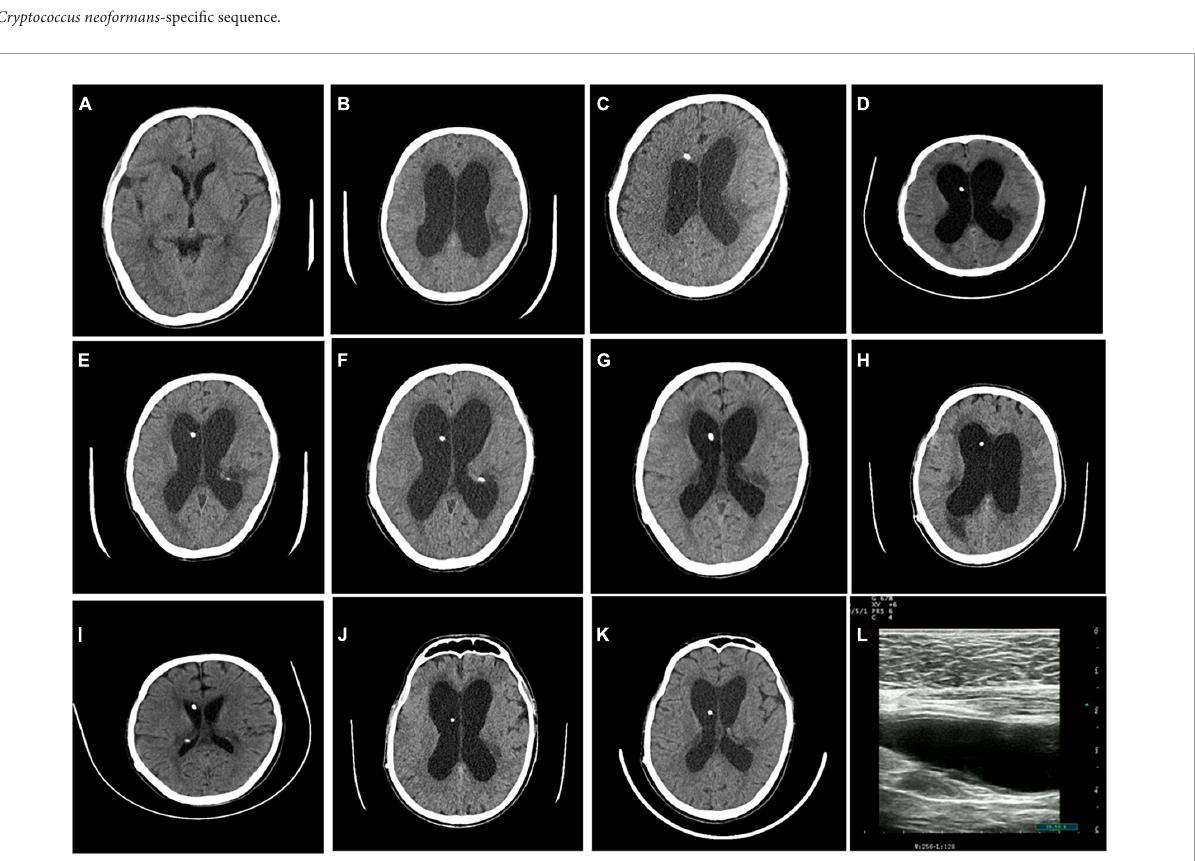
FIGURE1 Cranial CT findings during the patient’s six hospitalizations. No hydrocephalus was observed during the first hospitalization (A) . Hydrocephalus was visible before the operation during the second hospitalization (B) , and hydrocephalus was relieved post-operatively (C) . Hydrocephalus was visible before the operation during the third hospitalization (D) , and hydrocephalus was relieved post-operatively (E) . Hydrocephalus was visible before the operation during the fourth hospitalization (F) , and hydrocephalus was relieved post-operatively (G) . Hydrocephalus was visible before the operation during the fifth hospitalization (H) , and hydrocephalus was relieved post-operatively (I) . Hydrocephalus was visible before the operation during the sixth hospitalization (J) , and hydrocephalus was relieved post-operatively (K) . Abdominal ultrasonography before surgery suggested an intra-abdominal encapsulated effusion (L)